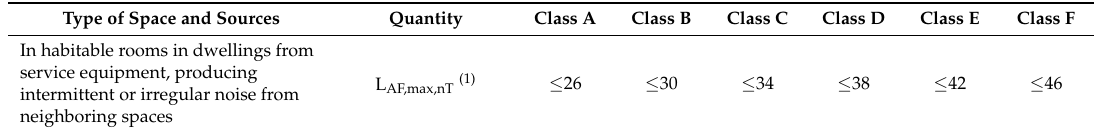
Table 3. Class limits for service equipment noise from neighboring spaces (The 2nd ISO/CD 19488).